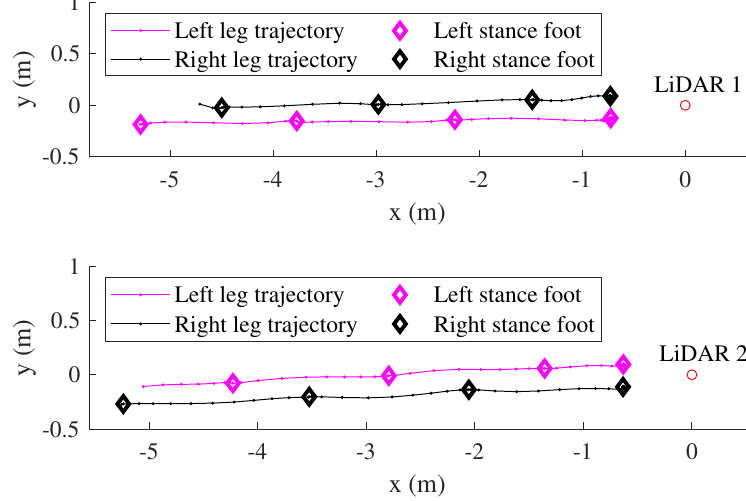
Figure 3. Estimation of the human leg trajectories from each